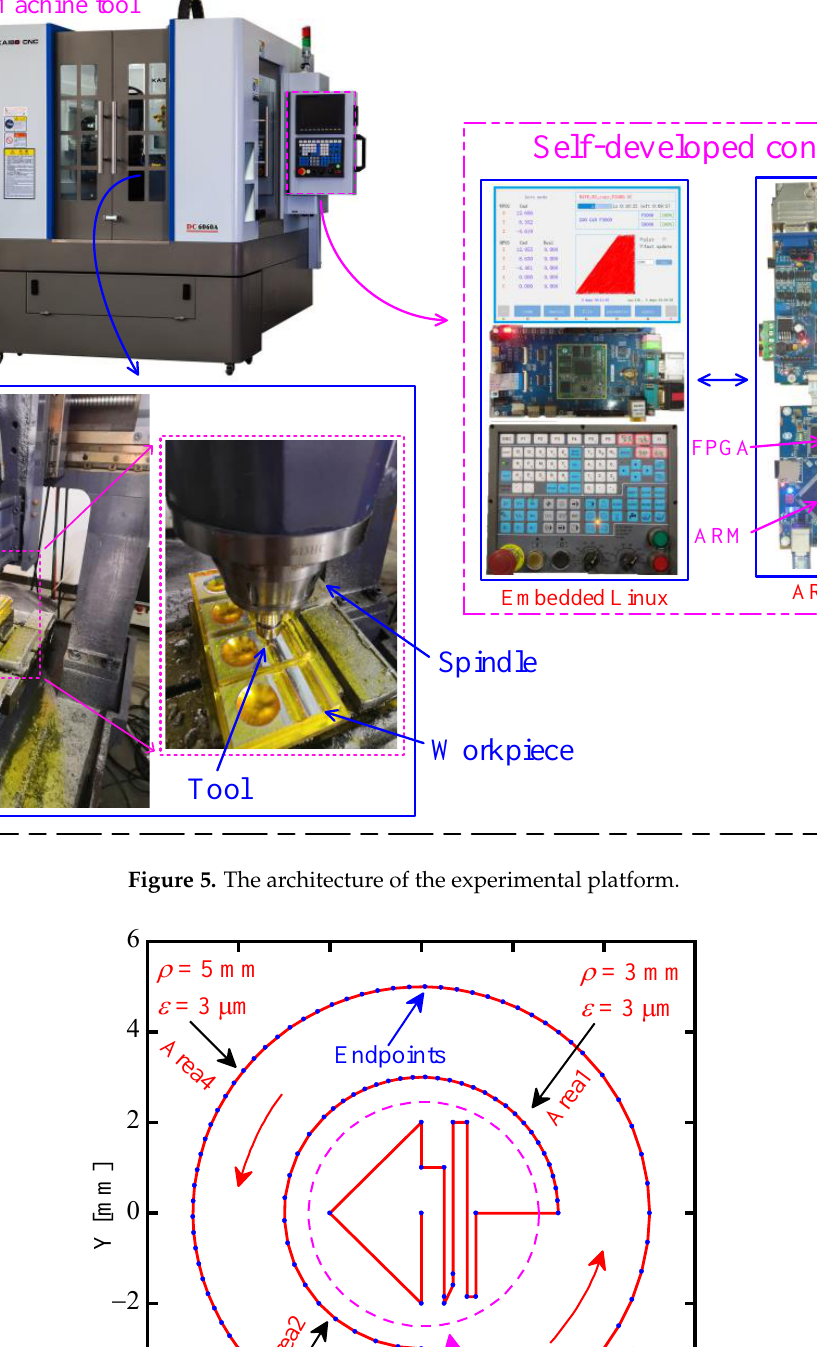
Figure 5. The architecture of the experimental platform.